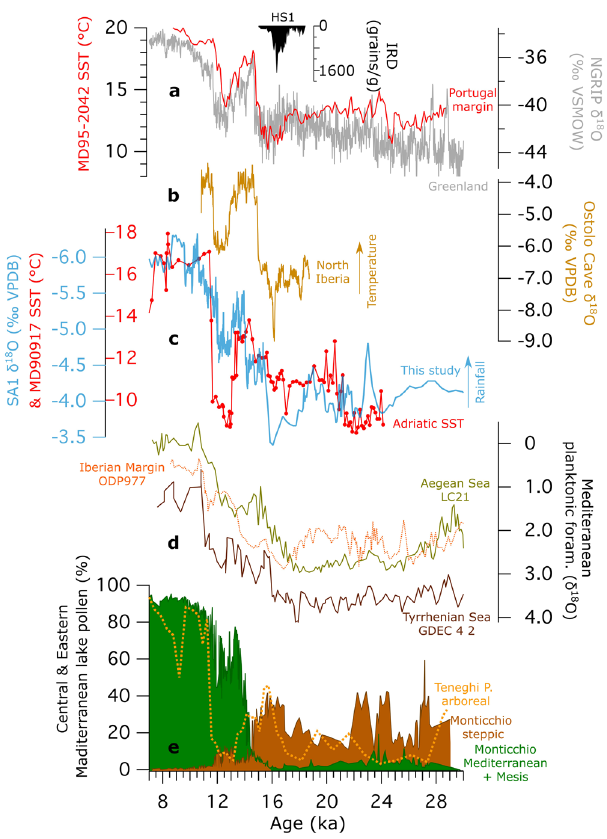
Fig. 2 SA1 hydroclimate proxies compared to Greenland ice-core data and the Iberian precipitation index. a δ 18 O Greenland ice-core time series (grey line 10 ) with highlighted GI1 (BA-chronozone), GS1 (YD-chronozone) and Holocene, together with the precipitation index (P-Index) from southern Iberia (blue line 24 ). b SA1 δ 18 O time series with age uncertainty error bars. c SA1 initial 234 U/ 238 U activity ratio and d ) growth rate. Peaks of GI2.1 and GS2.1a are marked with a green and pink circle, respectively. The red arrow indicates the gradual warming after peak GS2.1a conditions in Greenland. The black arrows highlight the rapid rainfall variation in the study site and northern Iberia after the same event. Steps 1 and 2 indicate the progression toward GI1 captured in SA1 (see text). The blue double-arrow shows an intra- Holocene dry interval recorded by both SA1 and the P-Index.